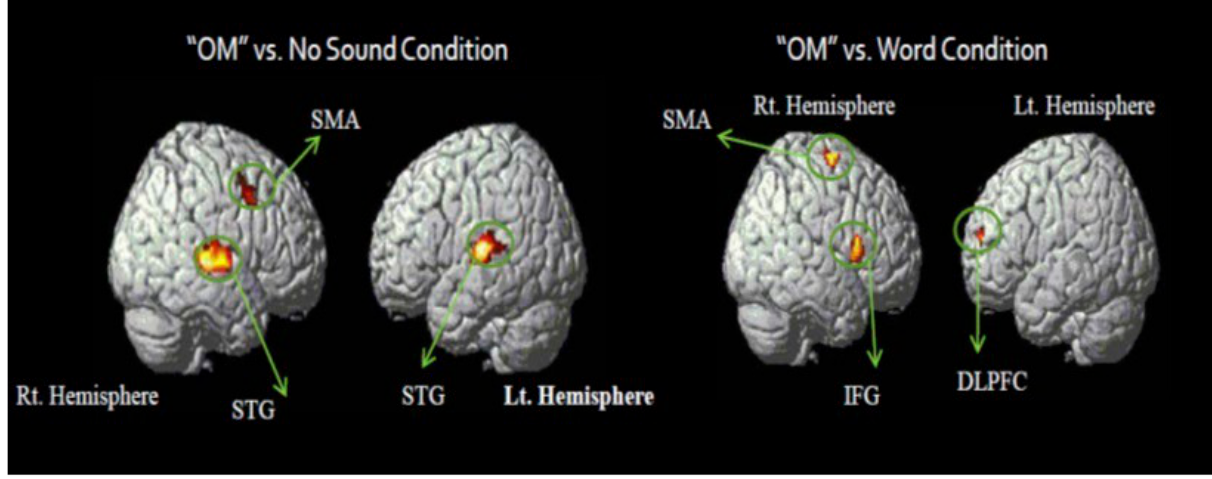
Figure 7. Neuro-cognitive effect of “OM” sound. (Supplementary Motor Area (SMA):Involved in MotorcoordinationSuperior tempo- ral gyrus (STG): Auditory perceptionInferior frontal gyrus (IFG): Perception of pleasant soundDorso-lateral pre-frontal cortex (DLPC): involved in monitoring of attention